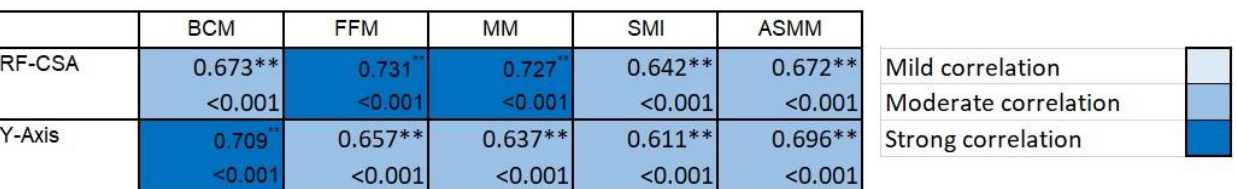
Figure 4. Correlation of the rectus femoris (RF) measurement by ultrasound and bioelectrical meas- urement in post-critical COVID-19 outpatients. In the heat map, the lightest blue represents a corre- lation coefficient of less than 0.39, and the darkest blue color represents a correlation coefficient of 0.7; the larger the correlation coefficient, the darker the corresponding color. ** p < 0.01.